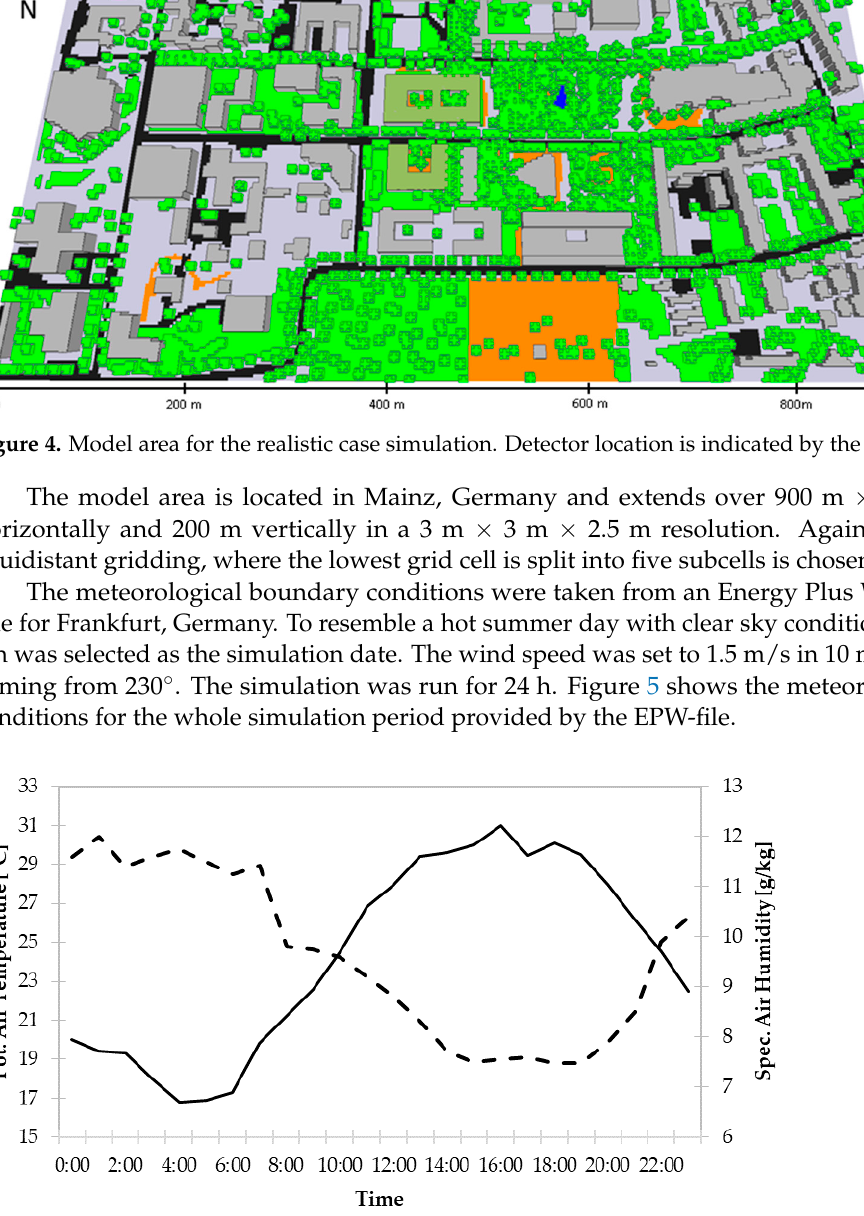
Figure 3. Model area for the simple inhomogeneous simulation featuring a building (black) a tree (green) and two detectors (blue and red).